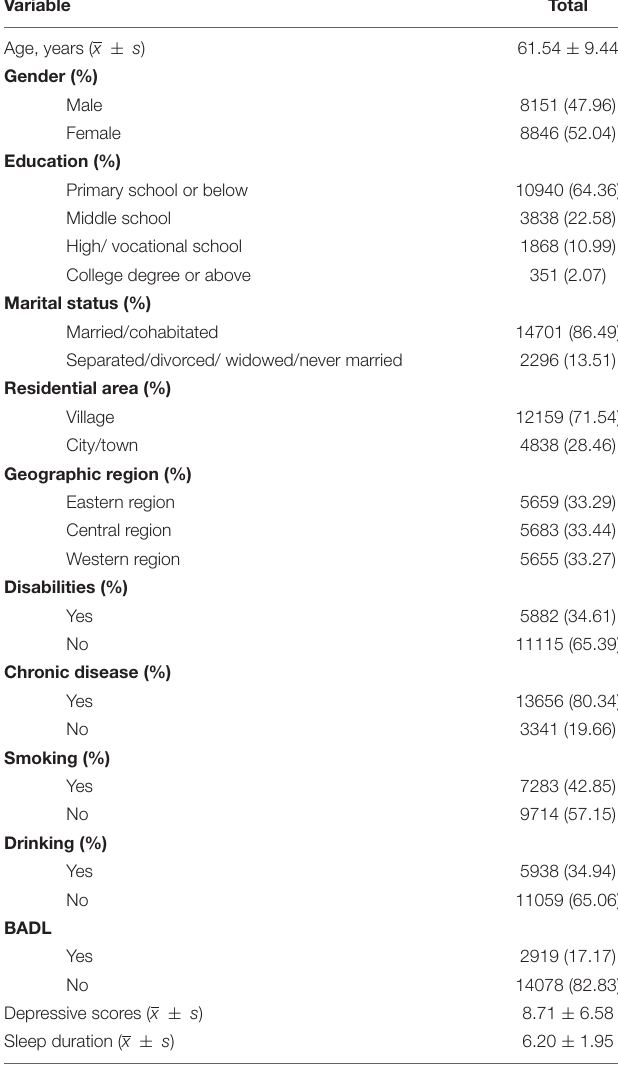
TABLE 1 | General characteristics of participants ( n =